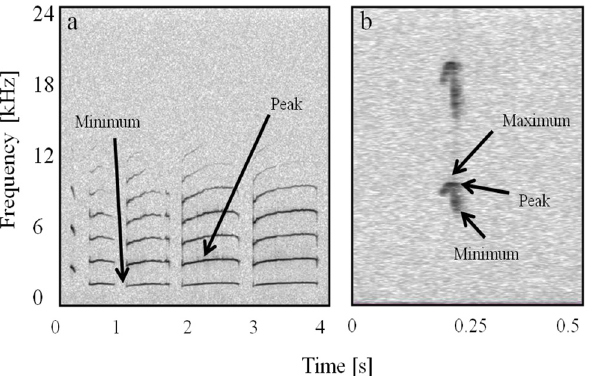
Fig 3. Spectrograms of CLC (a) and chirp (b) vocalizations with measured frequency characteristics indicated. This CLC consists of one chirp and four whistle syllables. All measurements of CLCs were made on the call as a whole and the individual syllables within the call (not shown); measurements of chirps were made from the fundamental frequency (first harmonic). Note that peak frequency measurements for all syllables, fundamental frequencies, and whole calls were taken automatically from the selection spectrum view in Raven 1.4 (not shown).